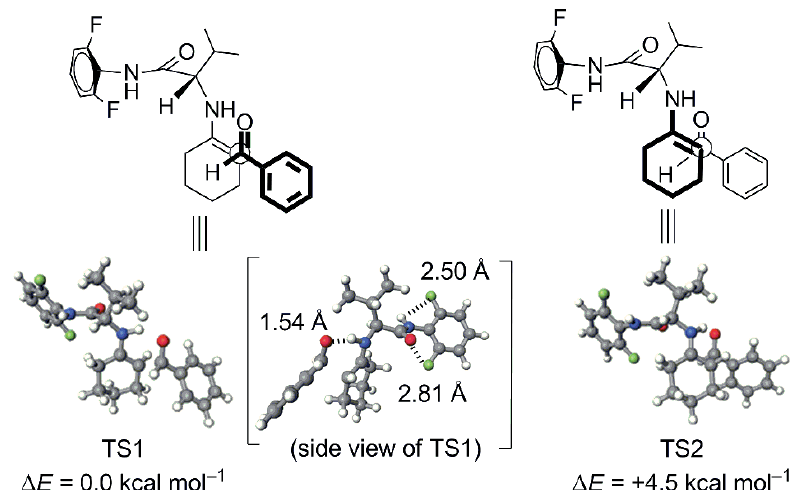
Figure 7. Calculated transition-state models for the asymmetric aldol reaction catalyzed by 11a .